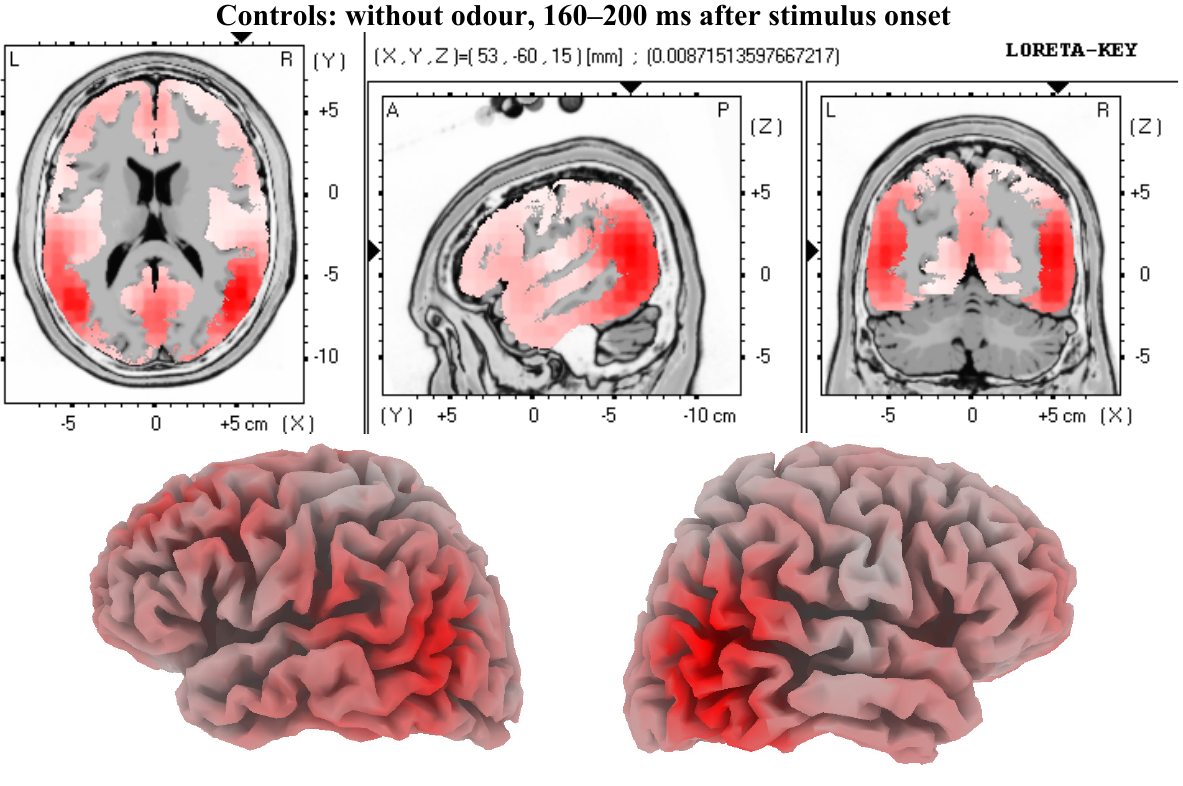
Controls: with odour, 160–200 ms after stimulus